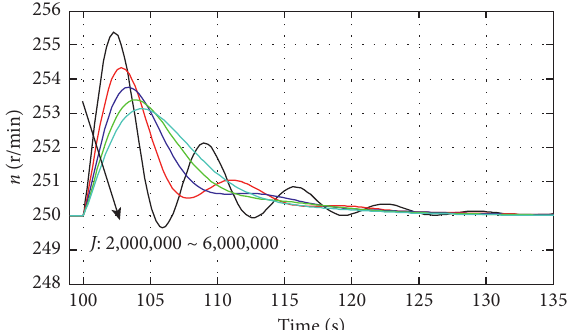
Figure 9: The influence of parameter T the unit to the power grid.